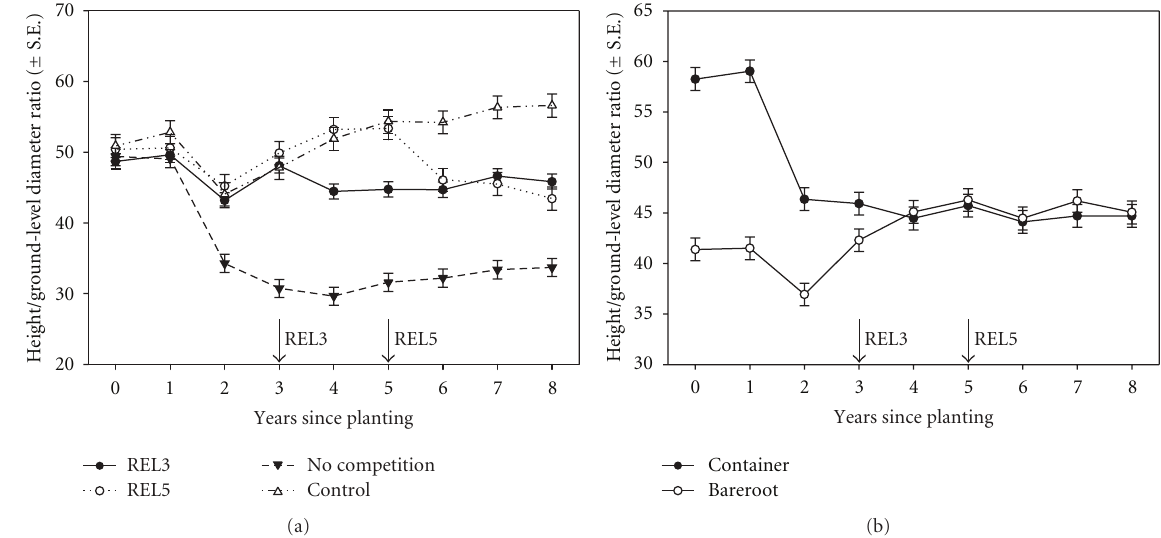
Figure 6: Profile of height/ground-level diameter ratio over eight growing seasons of large Picea glauca seedlings outplanted in south central Quebec (Canada). (a) Presents height/ground-level diameter ratio for each of four vegetation management treatments that were compared. Treatments consisted of four intensities of vegetation management, including a control, mechanical release during the third growing season (REL3), mechanical release during the fifth growing season (REL5), and plots where competition for light was eliminated through repeated herbicide and mechanical release treatments (No competition: NC). (b) Presents height/ground-level diameter ratio by stock